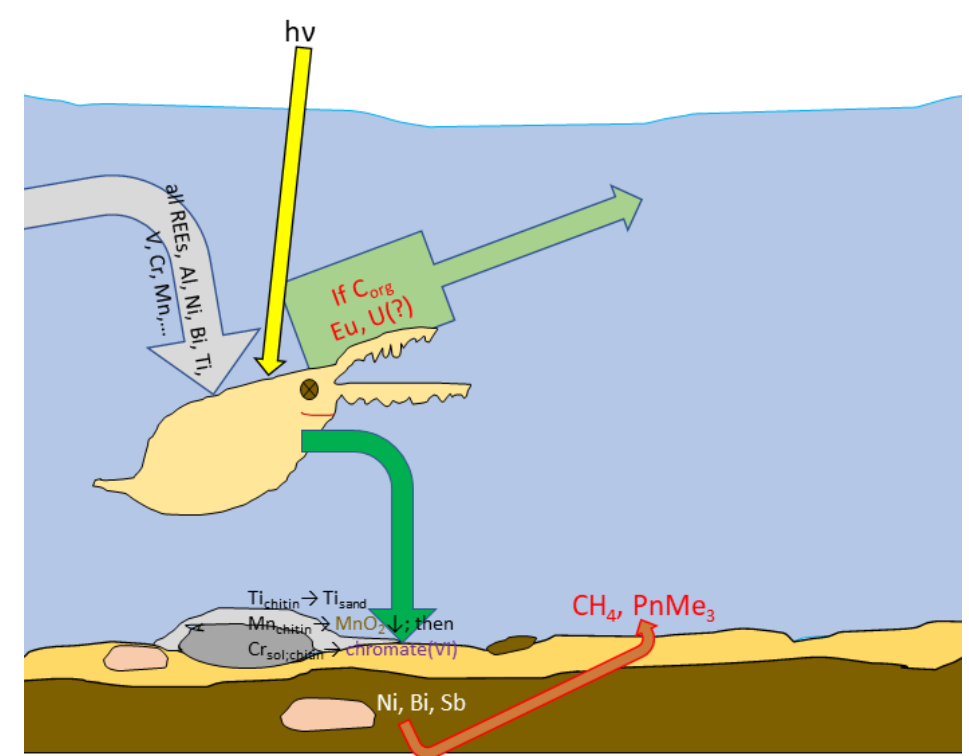
Figure 1. Daphnias bind (gray arrow) and transport (dark green arrow) metal ions by their diurnal migration patterns. If there is photoactive or especially phosphorylated organic matter, Eu (and U) will be released next to surface. Nighttime contact with sediment possibly transfers some components to the surface of arthropods (bottom). Actual quantitative extent of the depicted process is discussed in this paper.